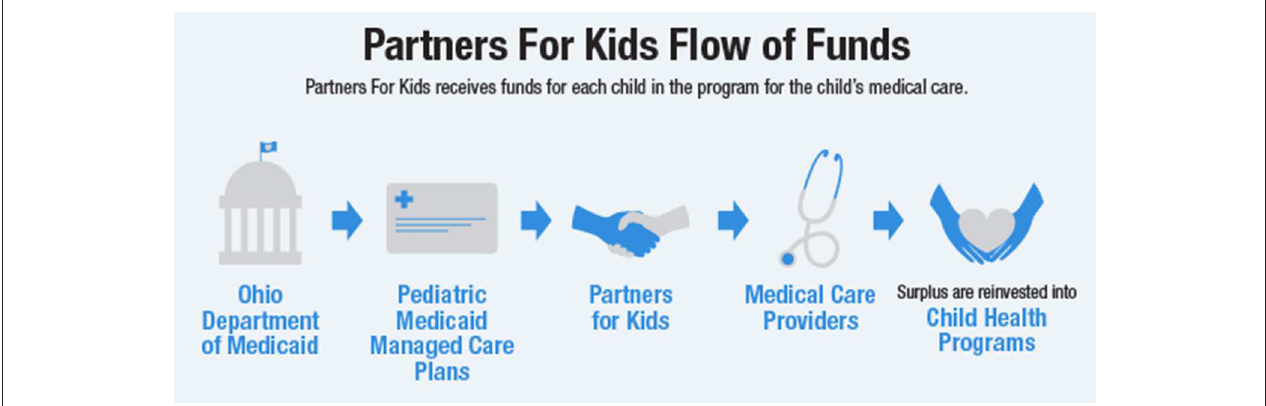
FIGURE 1 | Partners for Kids Flow of Funds: PFK receives funds to pay for each child’s medical care, the amount of which is defined as a capitation rate per child. A cost-saving model can achieve a surplus of funds, which are reinvested into programs that lead to improved health for children, such as school-based clinics and neighborhood programs.